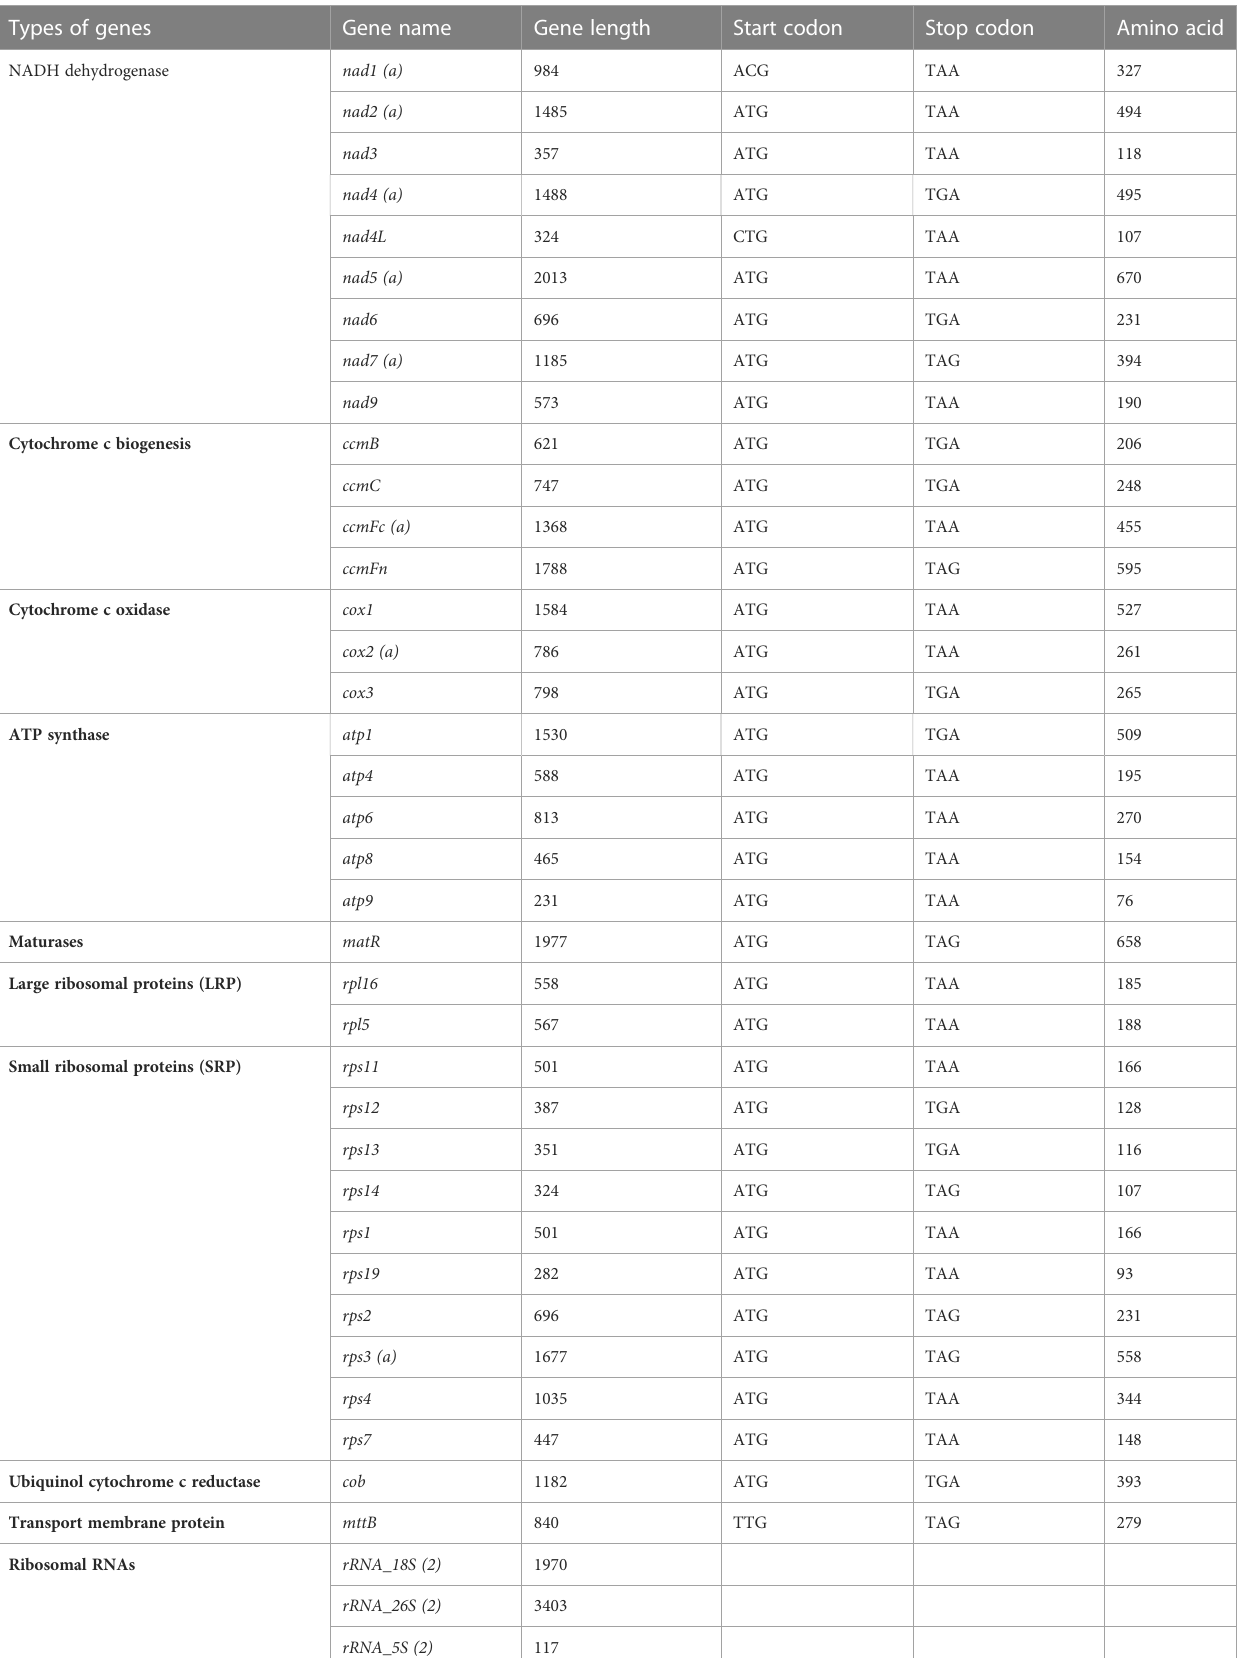
TABLE 1 Gene organization in the mitochondrial genome of A. of fi cinalis